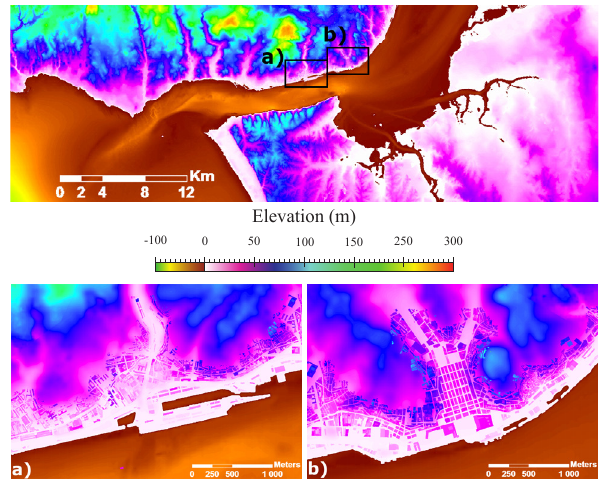
Fig. 7. Digital Elevation Model. Top: overview of the Tagus estu-